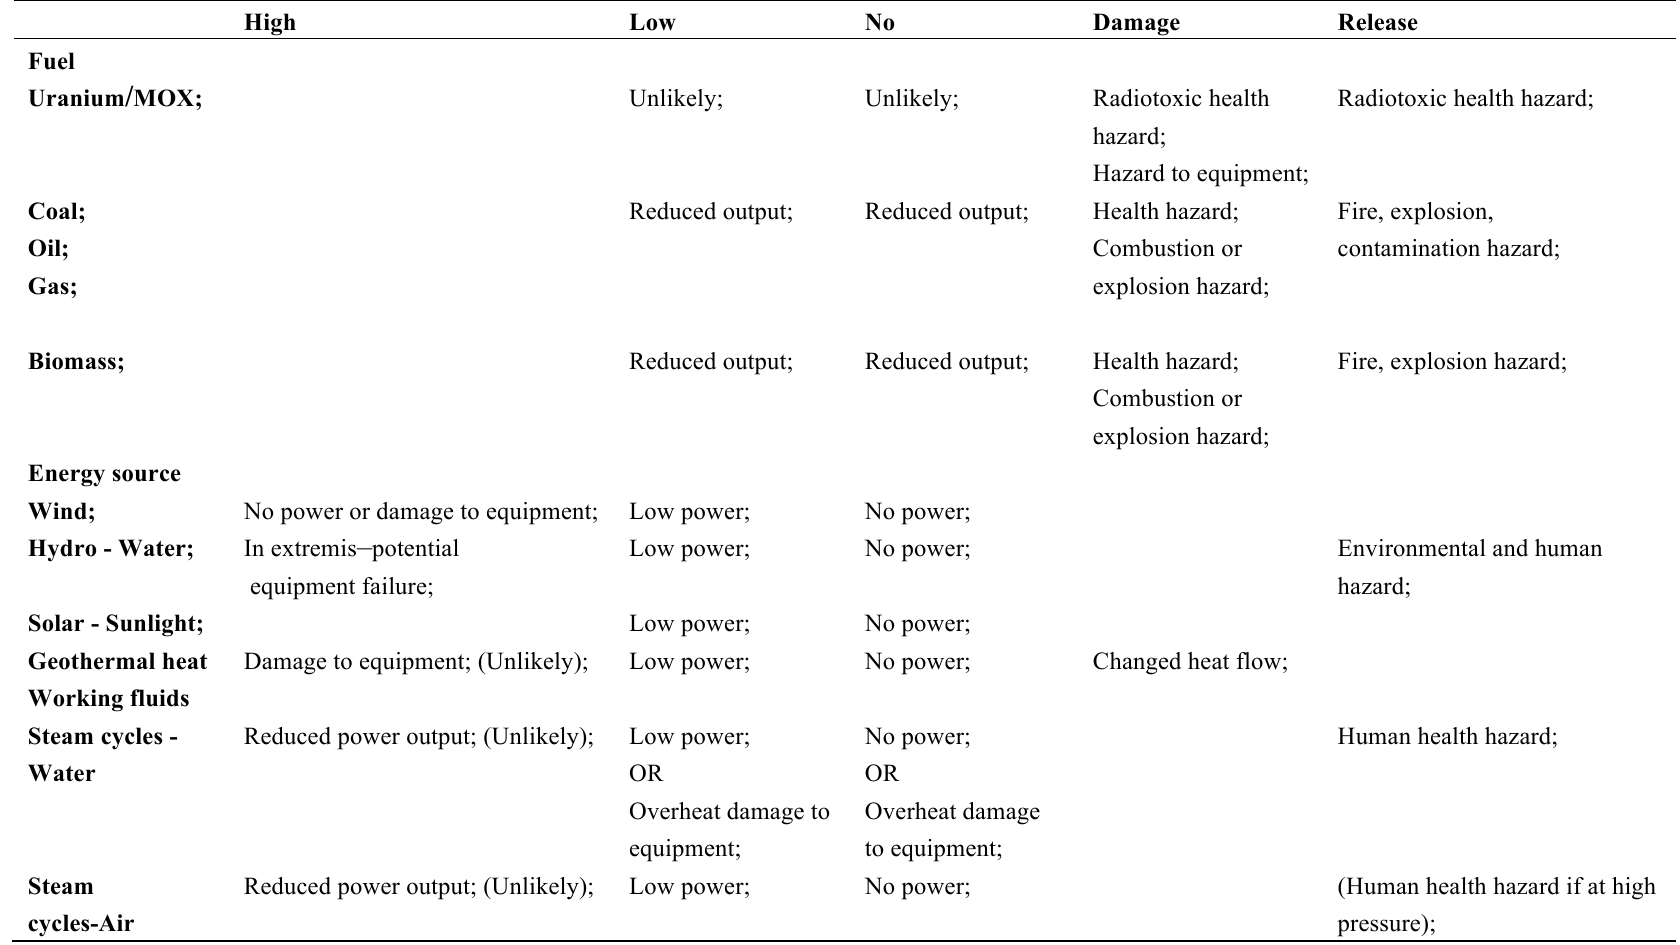
Table A1. Adapted-HAZOP assessment of risks associated with inputs of energy systems (blank = not applicable).